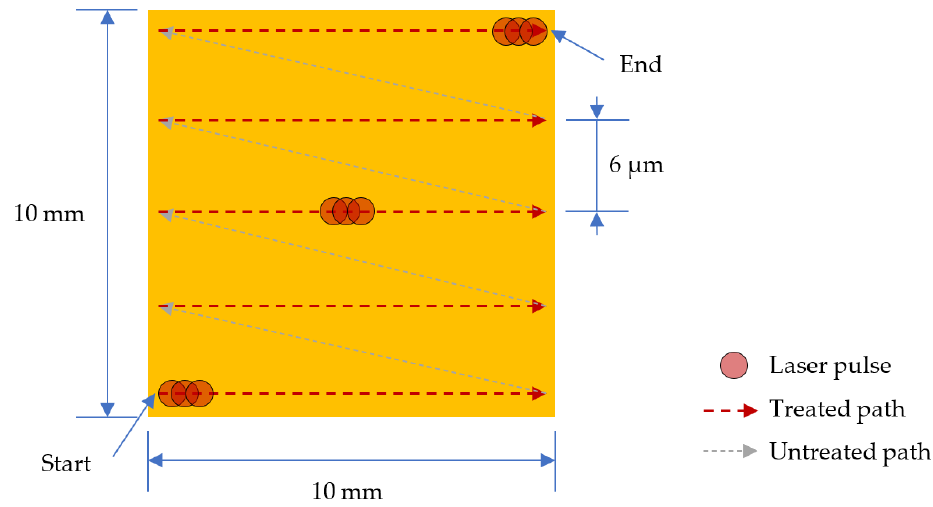
Figure 2. Laser beam scanning